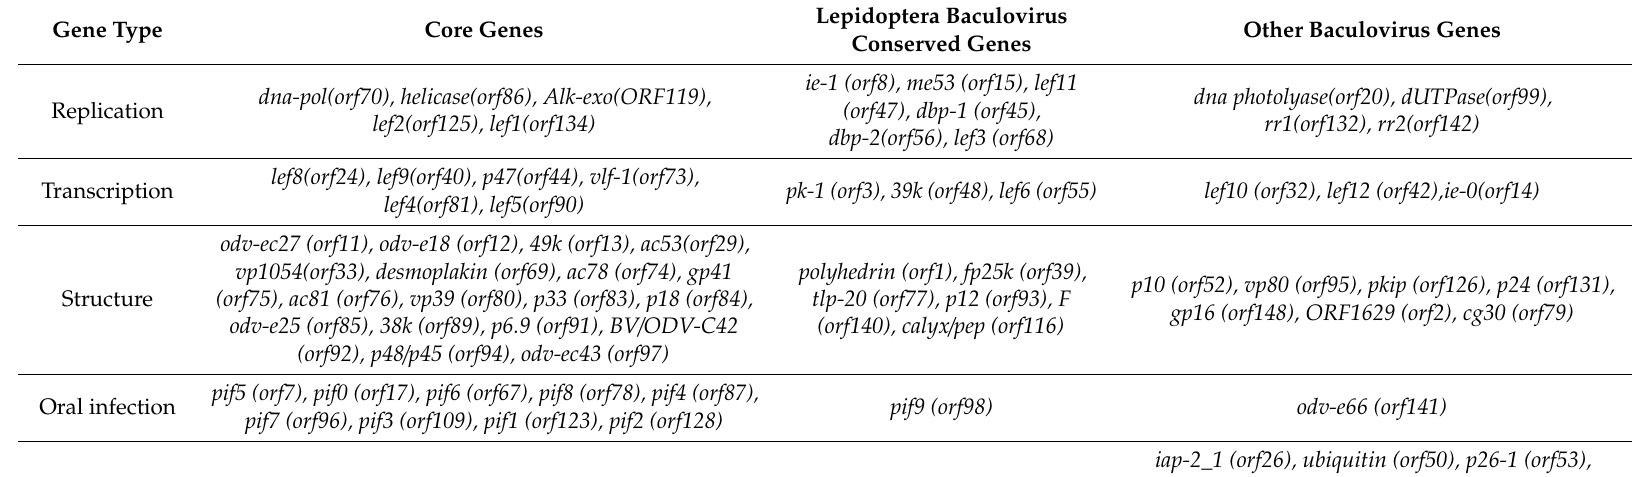
Table 1. Gene contents of